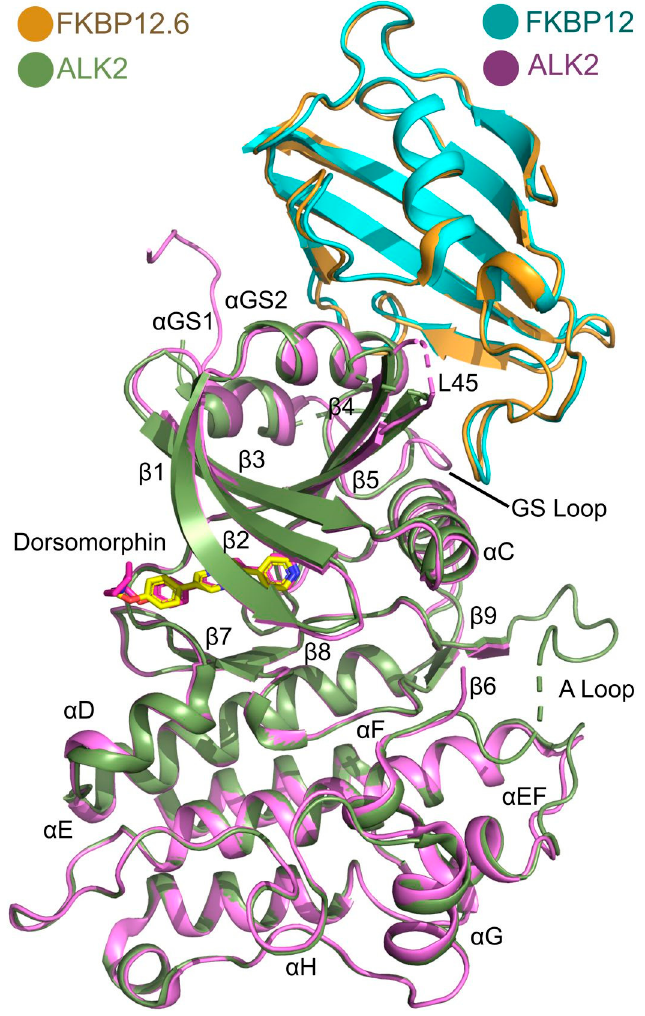
Figure 4. Structural comparison of ALK2 binding to FKBP12 and FKBP12.6. Superposition reveals high structural conservation between the ALK2-FKBP12.6-dorsomorphin complex (green/orange/yellow) and the previously reported structure of the ALK2-FKBP12-dorsomorphin complex (purple/cyan/magenta)(PDB 3H9R [14]).